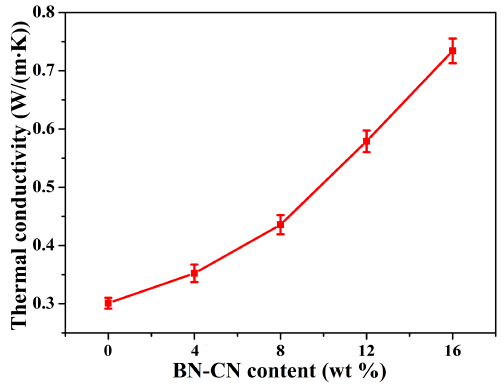
Figure 10. Thermal conductivity of the PEN-g-BN hybrids.